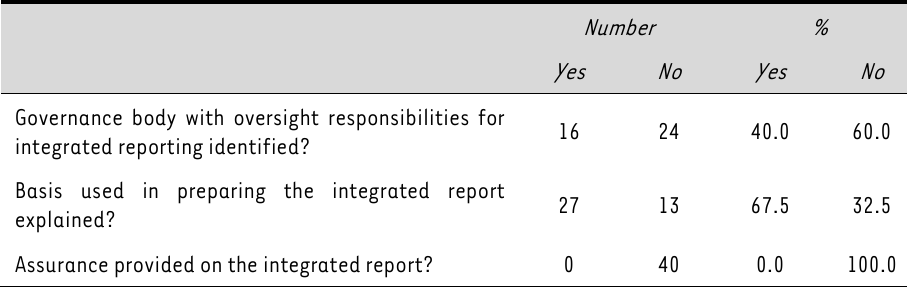
Number % Yes No Yes No